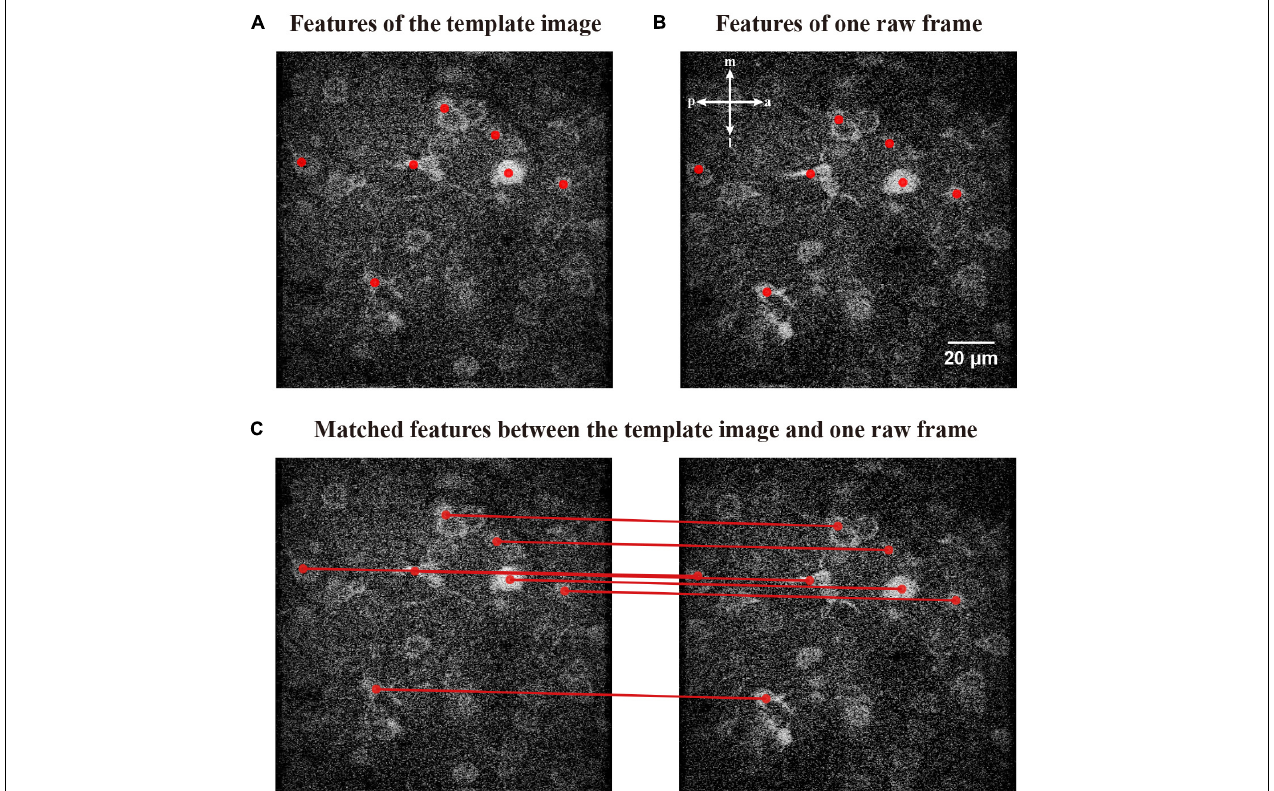
FIGURE 7 | Matching relationships between the features of template image and raw frame. (A) The features obtained by FIFER of the template image; features are marked by red dots. (B) A raw frame to be corrected with its corresponding features. (C) The corresponding coupling of the features; the matched relationships are indicated by red